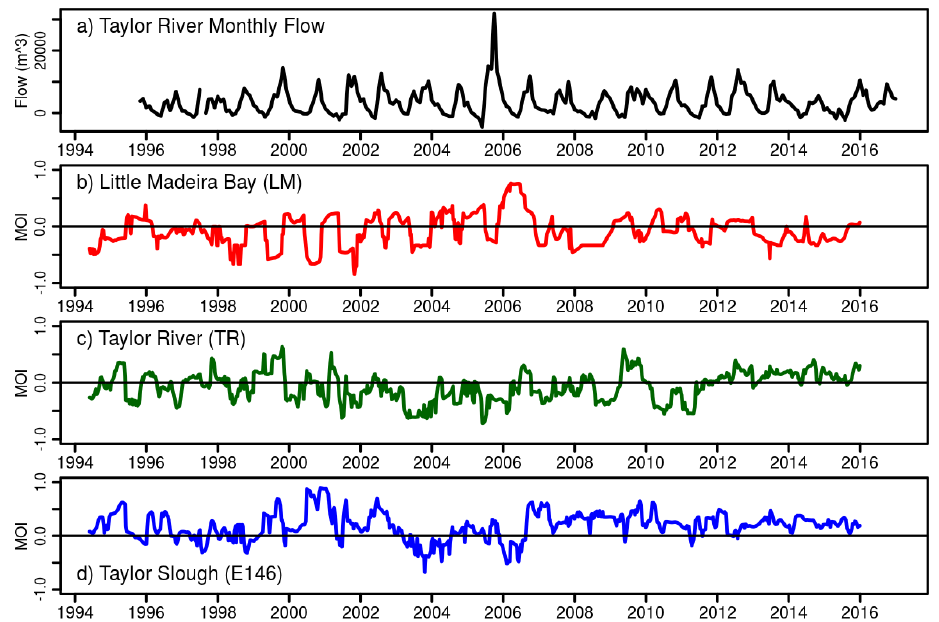
Figure 13. ( a ) Monthly stream flow at the terminus of Taylor River; ( b ) Marsh-to-Ocean Index (MOI) in Little Madeira Bay (LM) over a one year-long moving window advanced in 10-day increments; ( c ) MOI at the Taylor River (TR) station; ( d ) MOI at the E146 station in Taylor